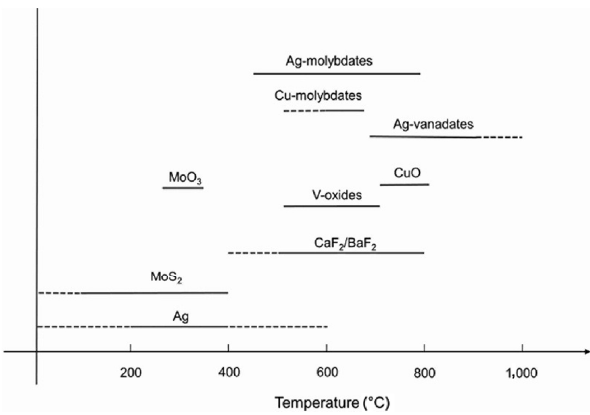
Fig. 24 Temperature ranges for effective lubrication for several solid lubricants. Reproduced with permission from Ref. [546]. © Taylor & Francis,